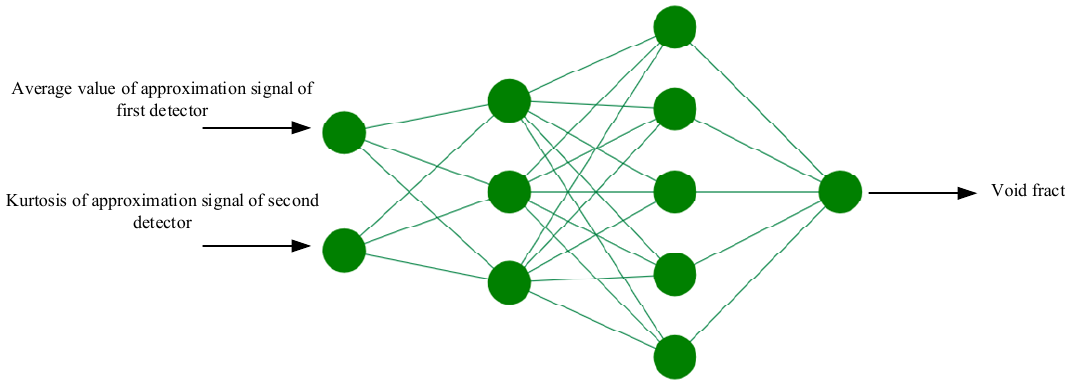
Figure 10. Network structure for predicting volumetric percentages. The performance of the implemented network for determining the void fractions of the training and testing datasets is illustrated in Figures 11 and 12, respectively.